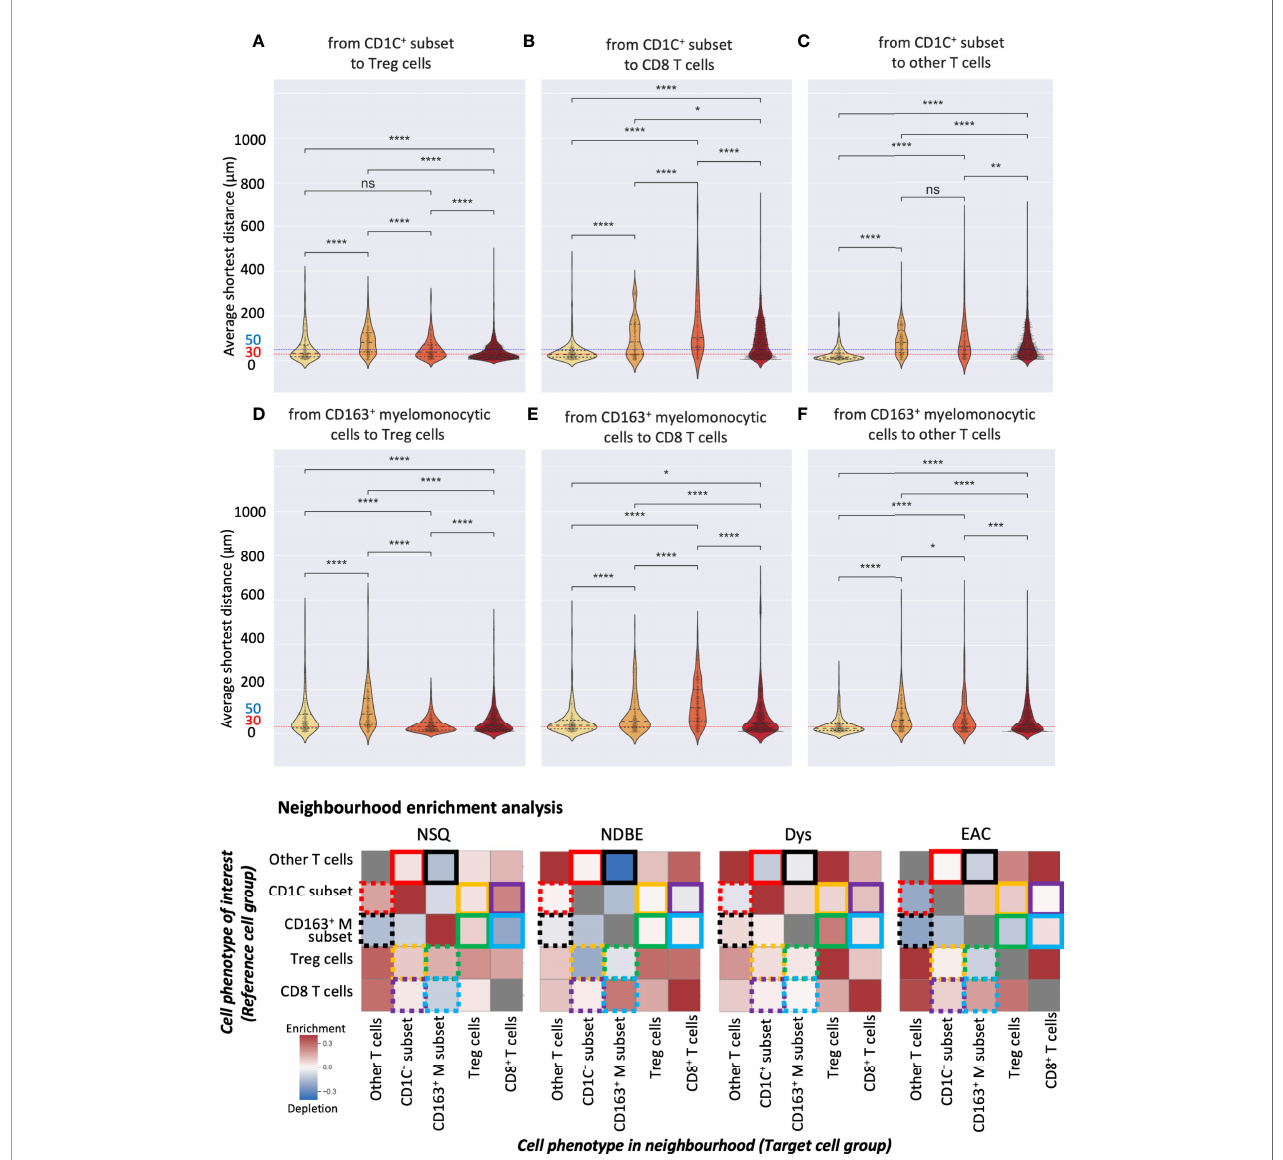
FIGURE 8 | SpatialanalysisofselectedSSCcellsubsets. (A – F) Average distanceanalysis: violinplotsrepresentedtheshortestaveragedistance fromonecellsubset to another.Statistics: Mann – Whitney – Wilcoxontesttwo-sidedwithBonferronicorrection:ns (not signi fi cant):p>0.05; *:p<=0.05; **:p<=0.01,***:p<=0.001, ****: p<=0.0001. (B) Neighborhoodenrichmentanalysis: the heatmaprepresentstheenrichmentor depletionofacellgroupintheneighborhoodofanother;coloredboxesdenotepairs ofcell subsets,e.g., yellowboxesdenotetheanalysis oftheCD1C + subsetandTregcells; eachboxrepresentstheenrichment/depletionofthetargetcellgroupinthe neighborhoodof thereferencecellgroupor cellphenotypeofinterest;grayboxes indicateenrichment/depletionthatis notsigni fi